Question: In a single sentence, describe what this figure presents.
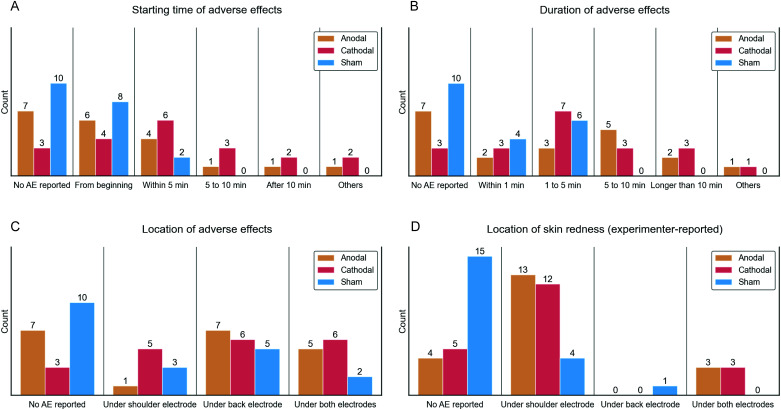
Answer: Temporal and spatial adverse effects patterns. Depicted reports of onset time (A), duration (B), location (C) of participant-reported AEs, and location (D) of experimenter-reported item across different stimulation conditions. Note that the category “Others” was introduced as some participants reported differences in onset times and durations of AEs for electrodes, thus preventing an assignment to a unique category. Bars represent absolute number of reports among the sample of 20 participants.